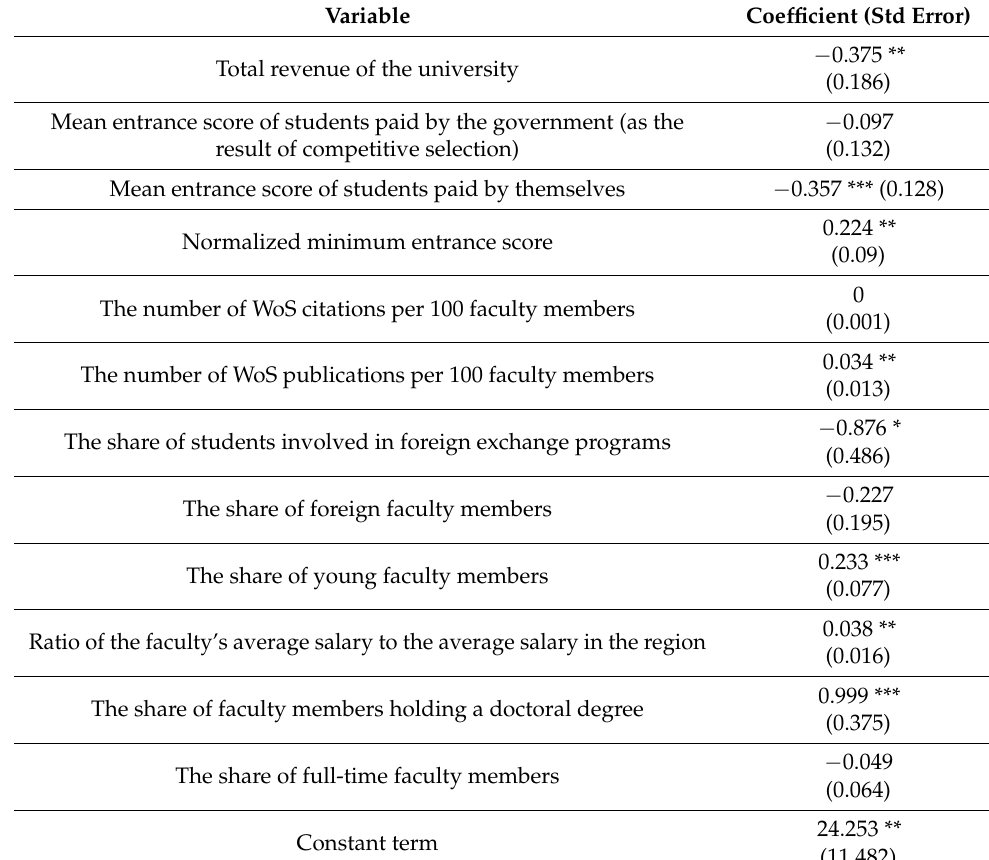
Table 3. Regression analysis. Dependent variable—R&D share in the total